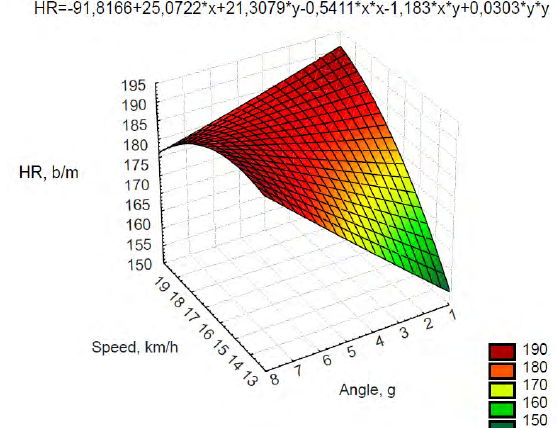
Fig.4. Model of ski racers’ HBR interdependence and speed of hills’ climbing, slope angle